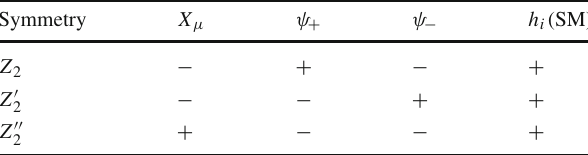
Table 1 Discrete symmetries of the vector-fermion DM model